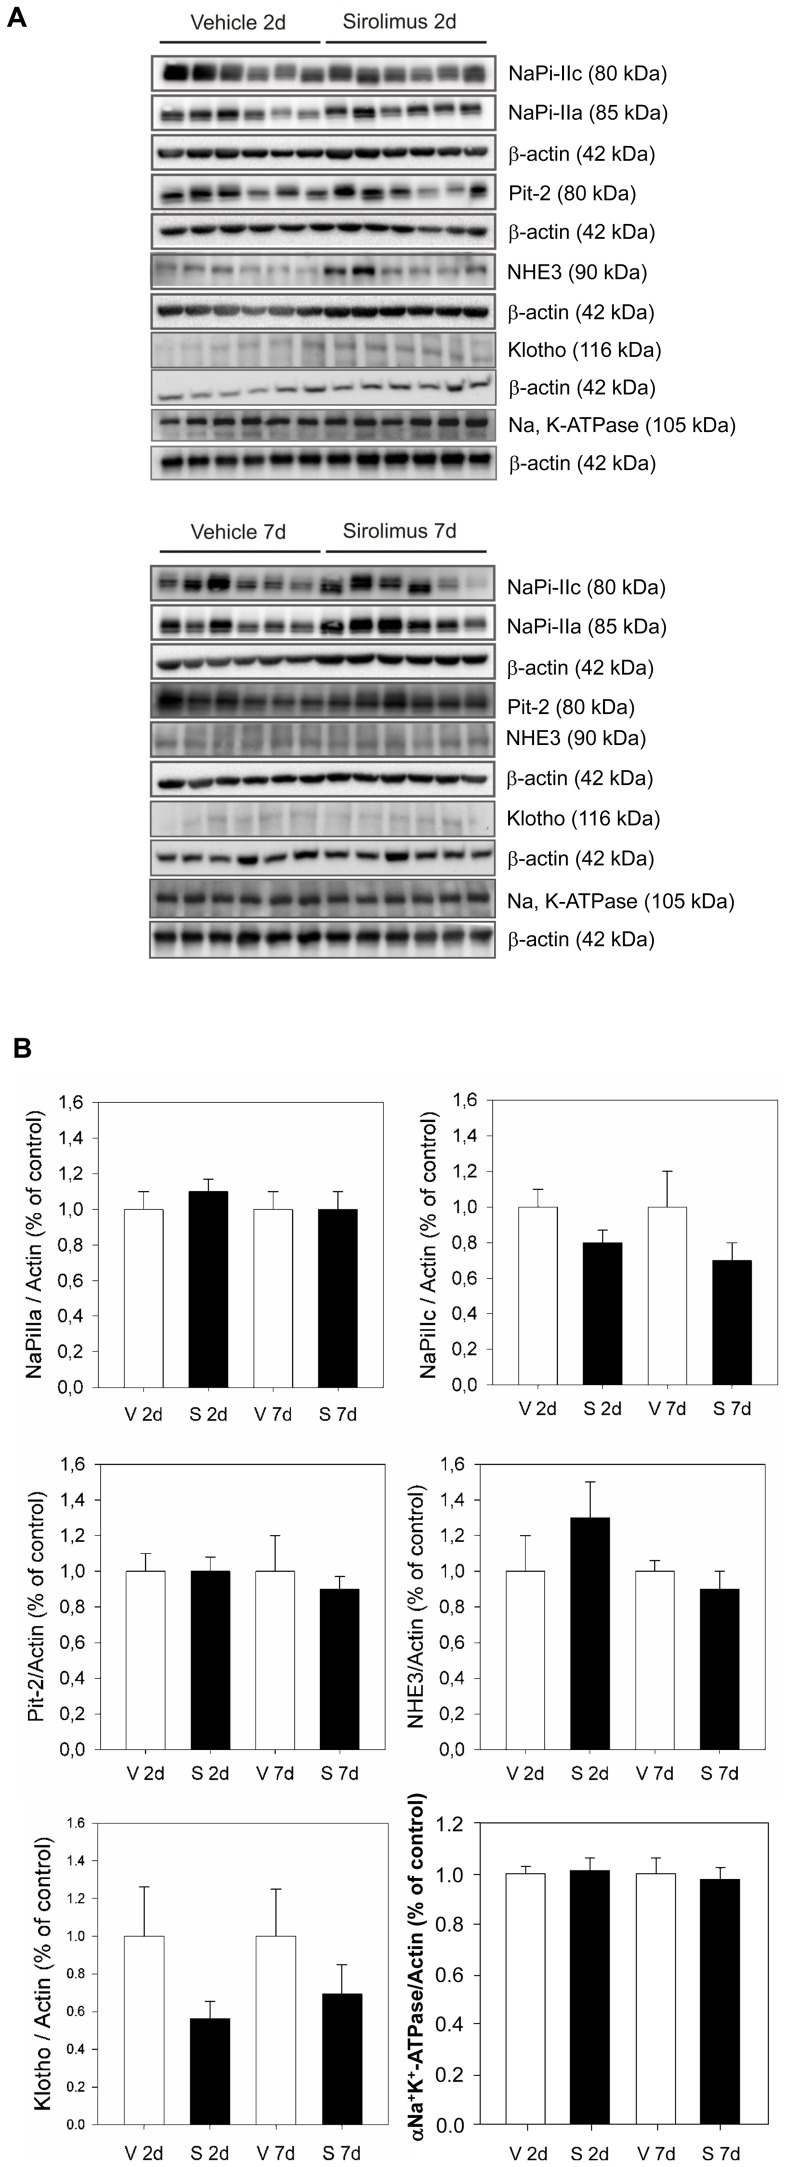
Sirolimus does not alter renal phosphate transporters.Sirolimus treatment for two and seven days does not alter protein expression levels of NaPi-IIa, NaPi-IIc, Pit-2, klotho and NHE3 in the brush border membrane. Brush border membranes or total membrane protein were prepared from kidneys of sirolimus and vehicle injected rats (n = 6) and 10 µg of brush border membranes or 35 µg of total membrane protein were loaded per lane for immunoblotting. a Membranes were tested for NaPi-IIa, NaPi-IIc, Pit-2, NHE3, and the αNa+/K+-ATPase subunit and stripped for reprobing with ß-actin to control for loading. b Densitometric analysis of all immunoblots with the appropriate software was performed and bands of the proteins of interest were normalized against ß-actin and the respective vehicle groups. Sirolimus treatment for two and seven days did not change the abundance of NaPi-IIa, NaPi-IIc, Pit-2, klotho and NHE3 compared to vehicle.